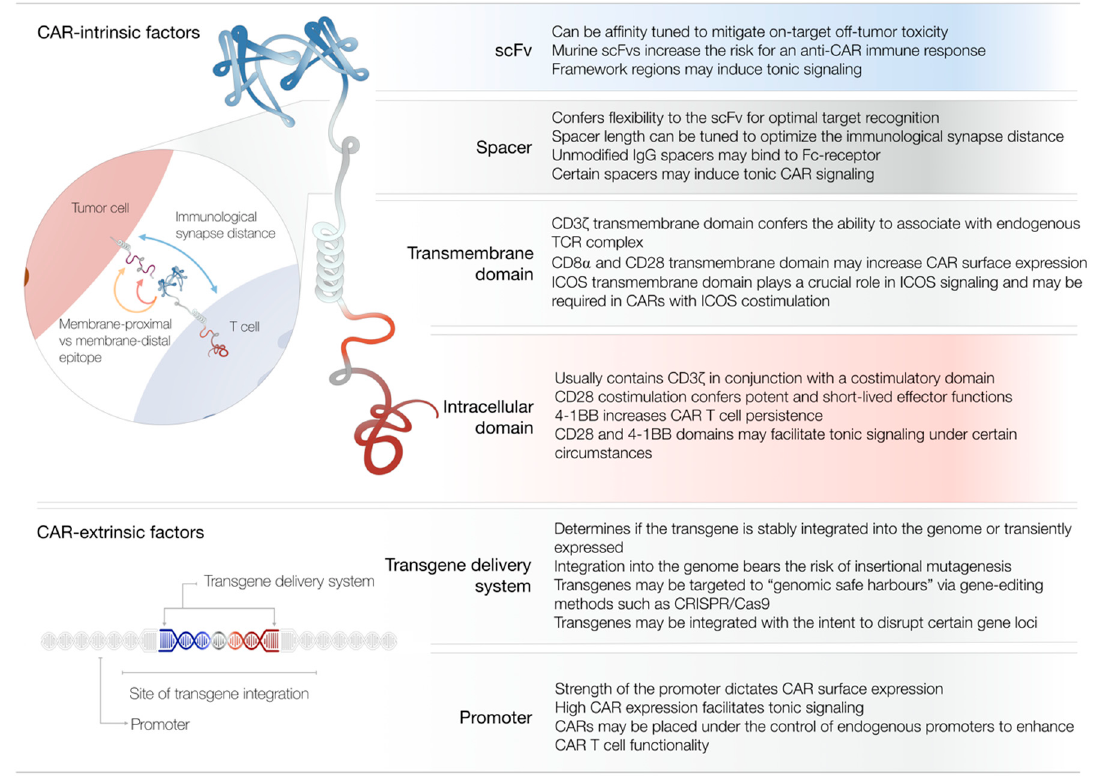
Figure 2. Summary of CAR-intrinsic and CAR-extrinsic factors of CAR T cell design. Depicted is a representation of a CAR molecule with its respective domains. The table lists the most notable contributions of individual domains to CAR T cell functionality. The zoom-in illustrates how the length of the spacer domain may influence the immunological synapse distance and confer flexibility for optimal target recognition. Abbreviations: Ig, immunoglobulin; ICOS, inducible T cell costimulator; CRISPR, clustered regularly interspaced short palindromic repeats.